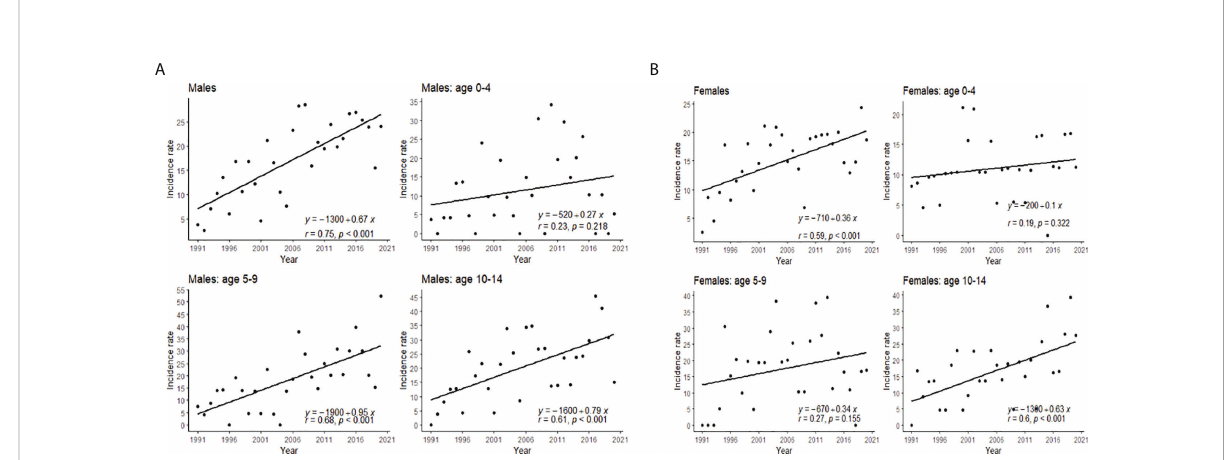
FIGURE 2 Trends of crude incidence rates of T1D in different age groups in (A) boys and (B) girls.